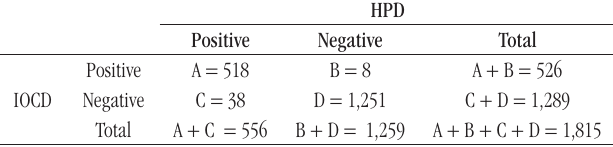
taBLE 4 – Relationship between IOCD and HPD in cases of IOC performed in thyroid lesions at Inca from January 2001 to December 2012 ( n = 1,815) HPD